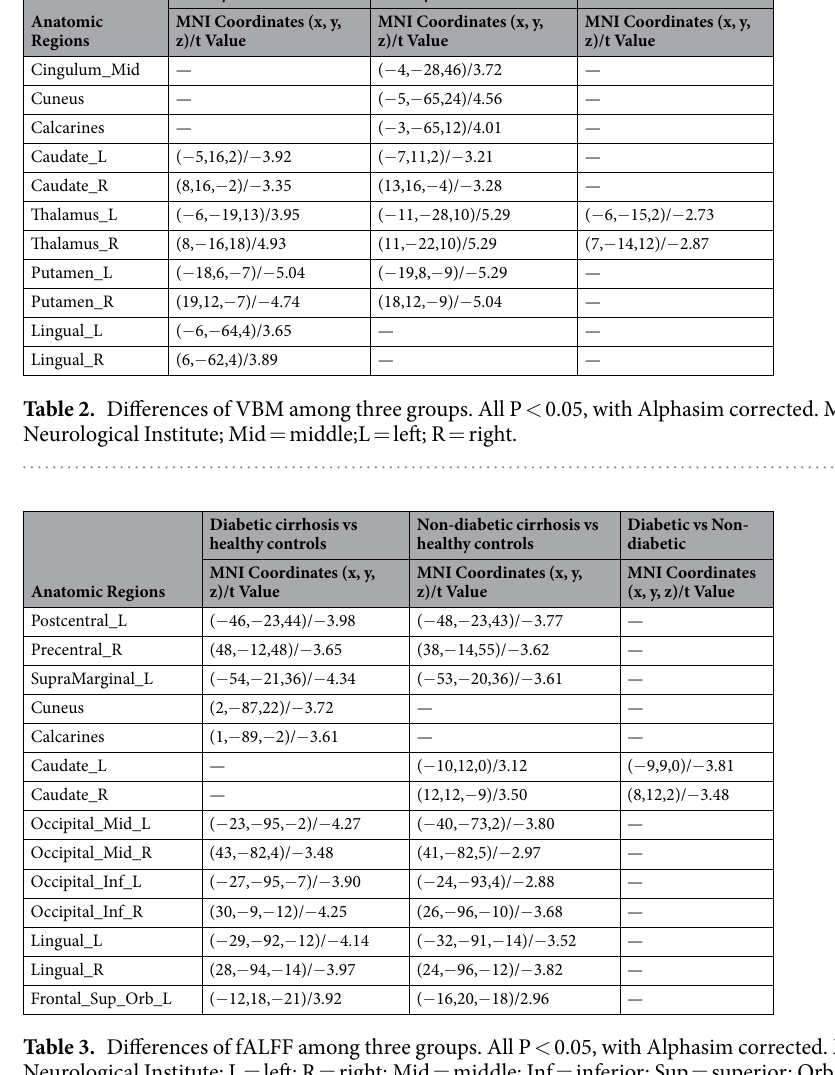
Table 3. Differences of fALFF among three groups. All P < 0.05, with Alphasim corrected. MNI = Montreal Neurological Institute; L = left; R = right; Mid = middle; Inf = inferior; Sup = superior; Orb = orbital.